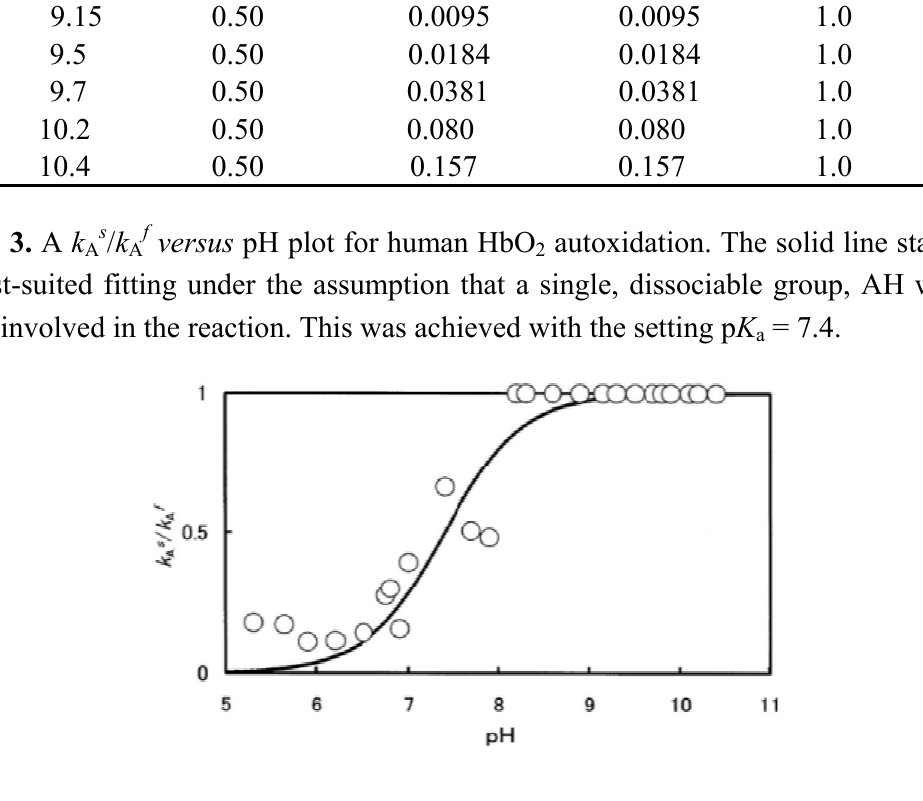
Table 1. Summary of kinetic parameters for the autoxidation of human HbO buffer obtained by least-squares fitting to the experimental data in each run.